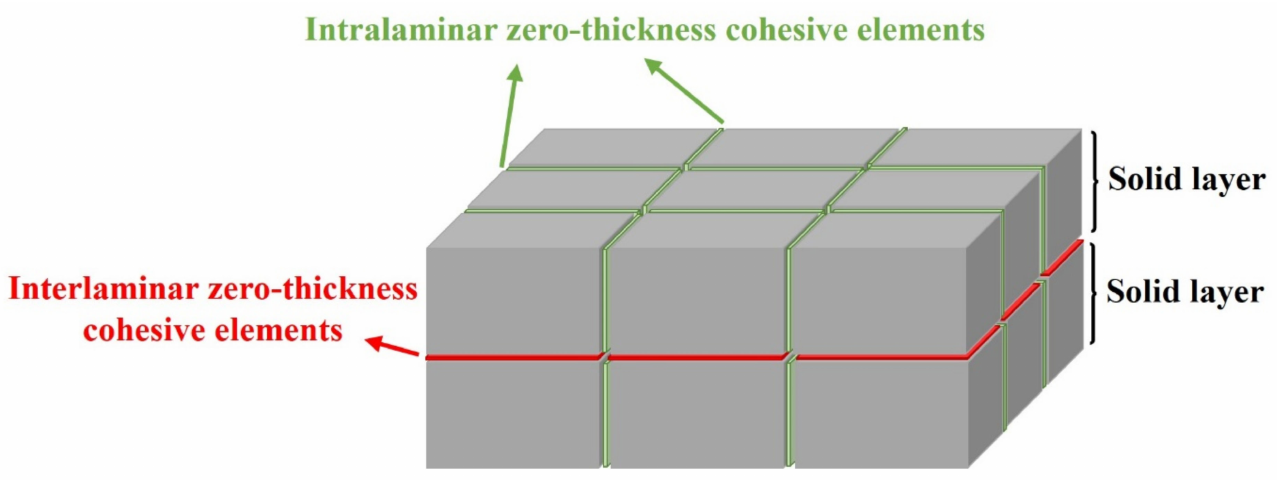
Figure 1. Schematic of the FDEM